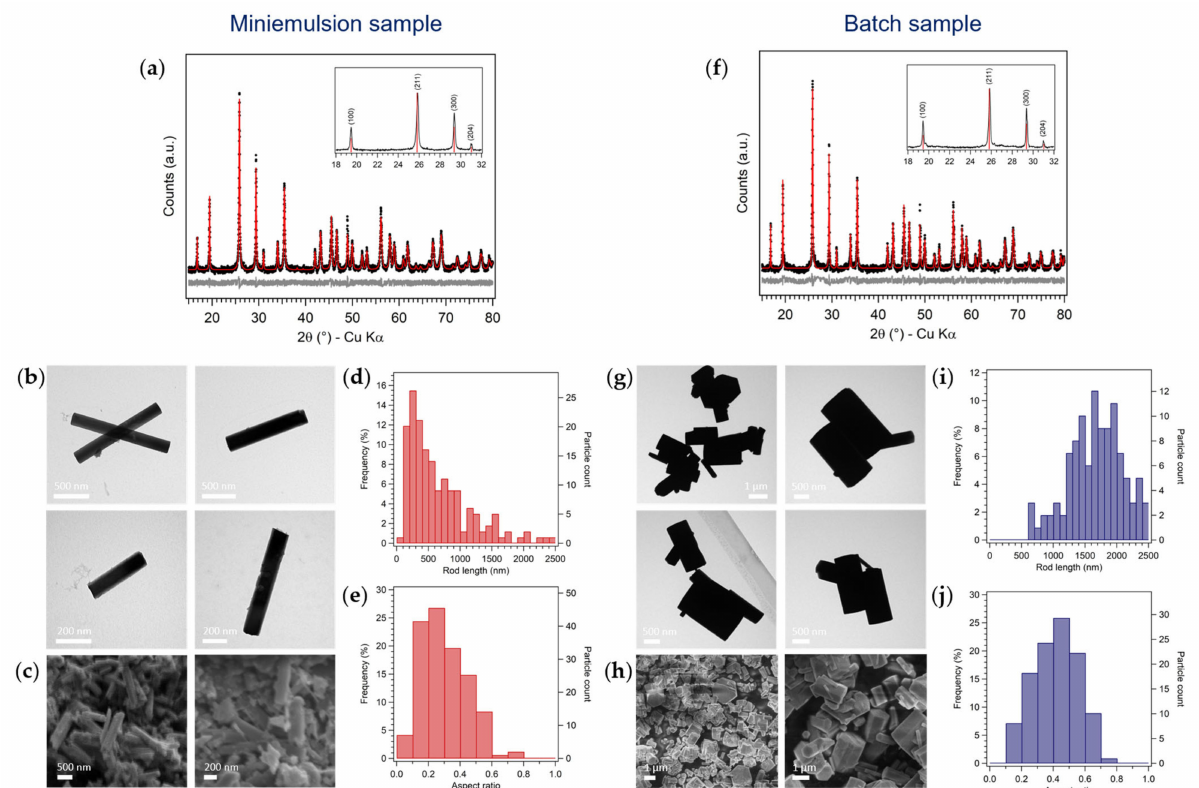
Figure 2. Characterization of ( a – e ) ME and ( f – j ) batch samples ([AHM] = 0.20 M, AHM:HNO 3 1:10 mol, 24 h): ( a , f ) XRD fittings, insets: XRD patterns (18–32 ◦ 2 θ ) superimposed with reference database pattern (red sticks); ( b , g ) TEM and ( c , h ) SEM micrographs; histograms representing the ( d , i ) rod length and ( e , j ) aspect ratio distributions of samples, estimated from TEM